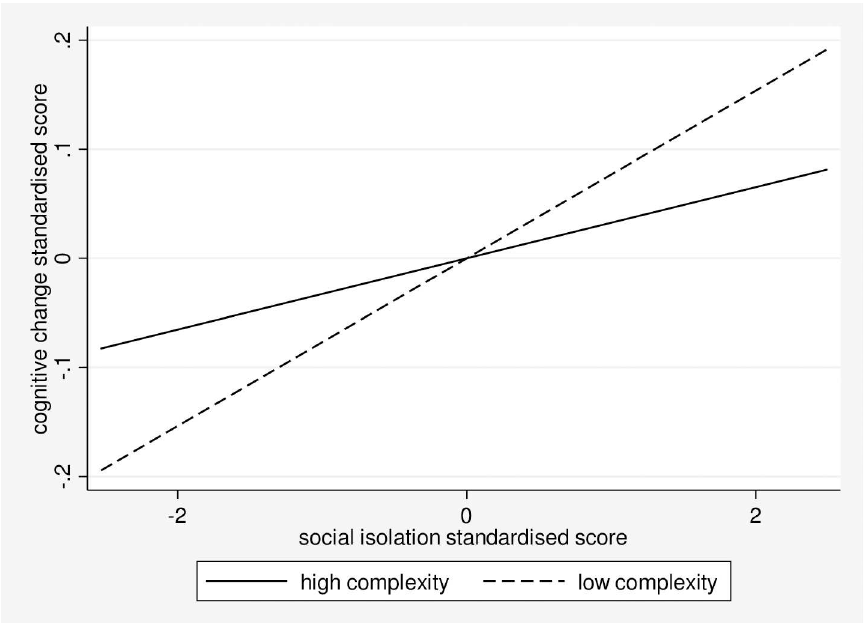
Fig 1. The association between social isolation and cognitive change by high and low occupational complexity